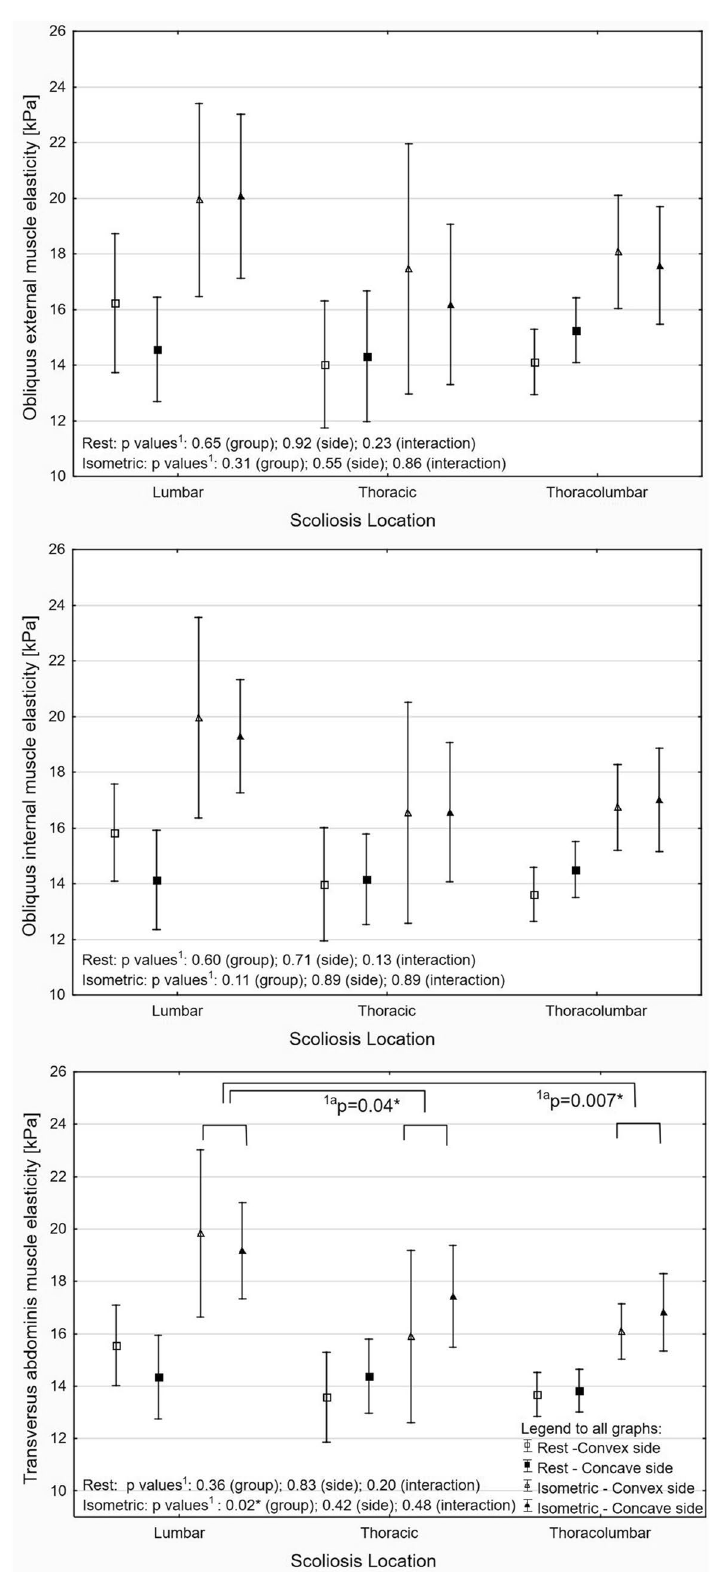
Figure 4. Shear modulus (elasticity) at rest and during isometric contraction in idiopathic scoliosis subgroups with p values from ANOVA 1 and planned comparisons 1a (*significant